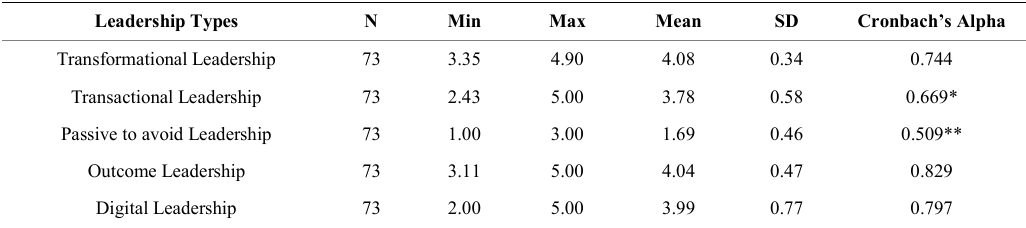
Figure 4. Sample Demographics (N=73). Table 2. Leadership Descriptives.